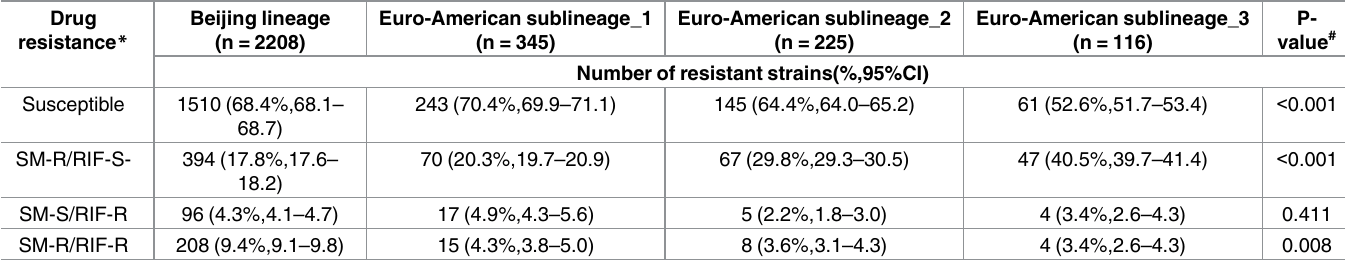
Table 3. Streptomycin and rifampicin resistance per complex.